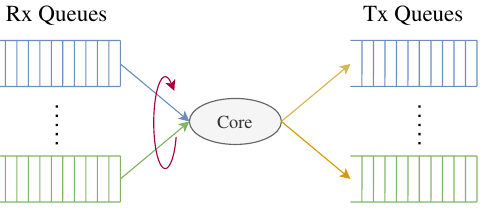
Figure 2. Schematic diagram of a single CPU working based on the spin-polling